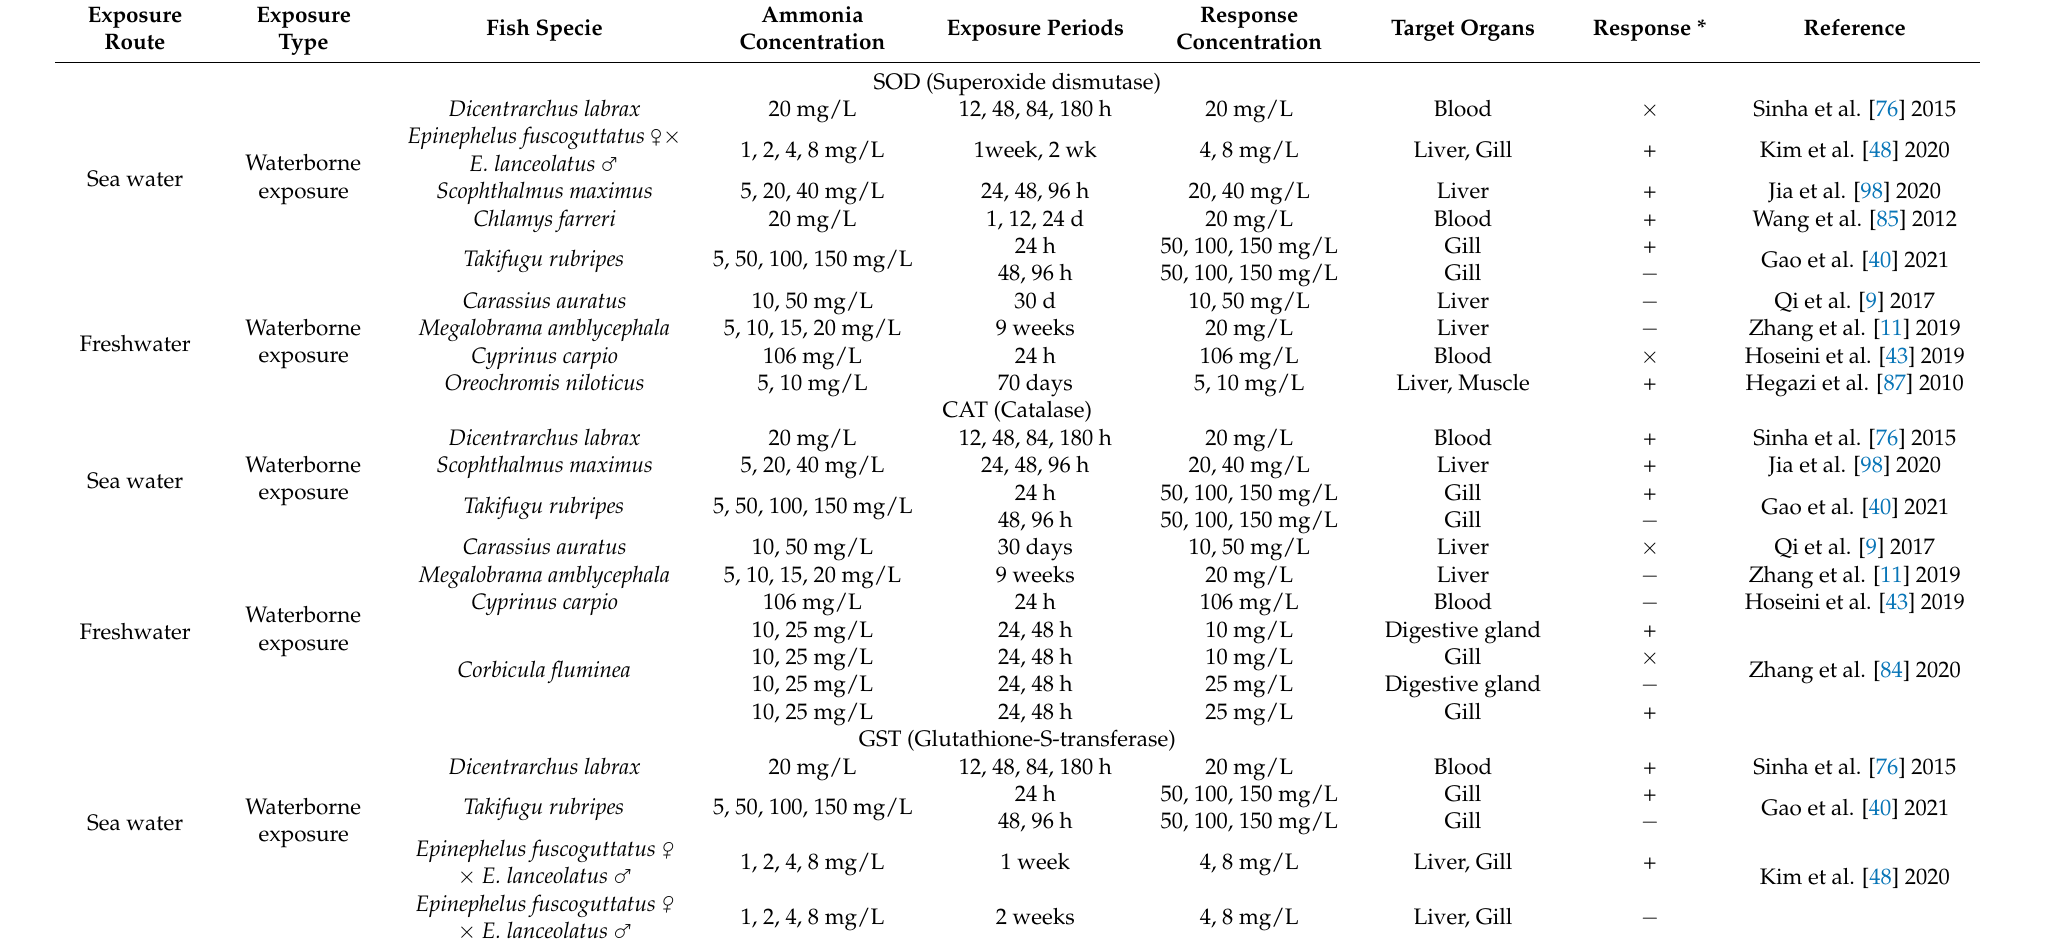
Table 2. Antioxidant enzyme responses such as SOD, CAT and GST in fish exposed to